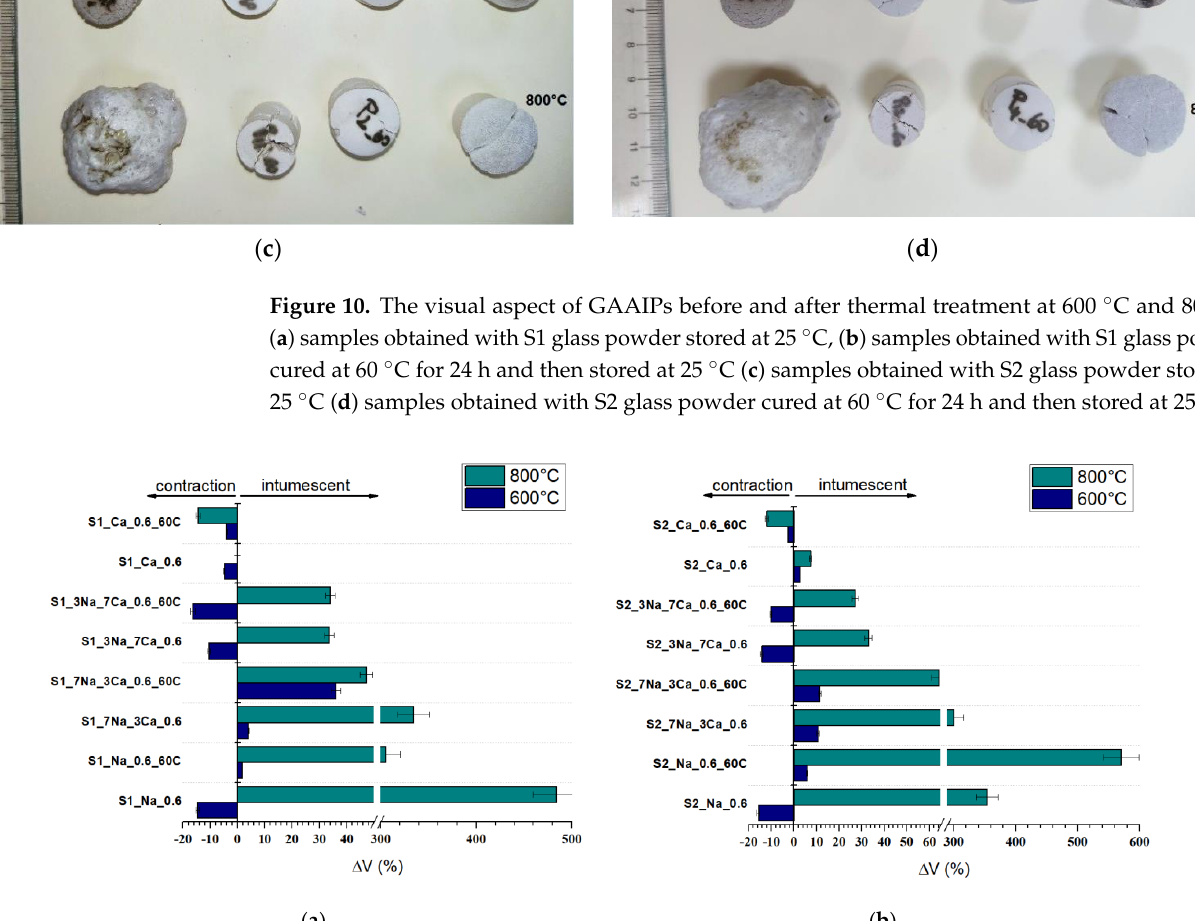
Figure 10. The visual aspect of GAAIPs before and after thermal treatment at 600 °C and 800 °C: ( a ) samples obtained with S1 glass powder stored at 25 °C, ( b ) samples obtained with S1 glass powder cured at 60 °C for 24h and then stored at 25 °C ( c ) samples obtained with S2 glass powder stored at